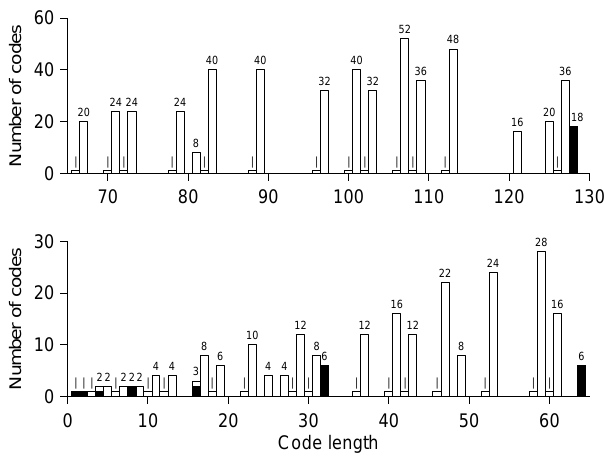
Fig. 1. Number of different alternating codes up to code length 130. The black bars represent the well-known binary phase alternating codes, the white bars represent new polyphase alternating